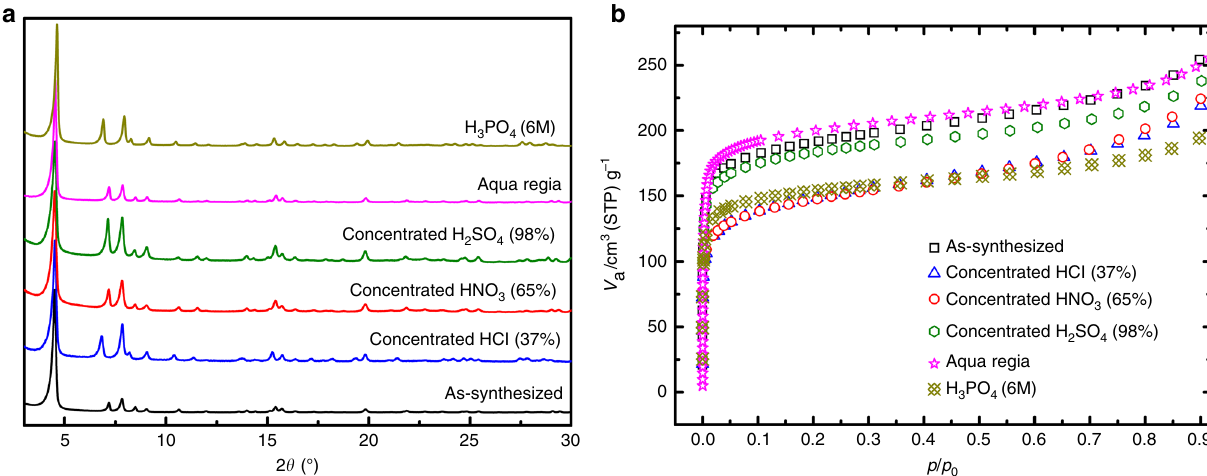
Fig. 3 Chemical stability test results of MIL-177-LT. a PXRD patterns and b nitrogen adsorption isotherms of MIL-177-LT samples before and after chemical treatment in